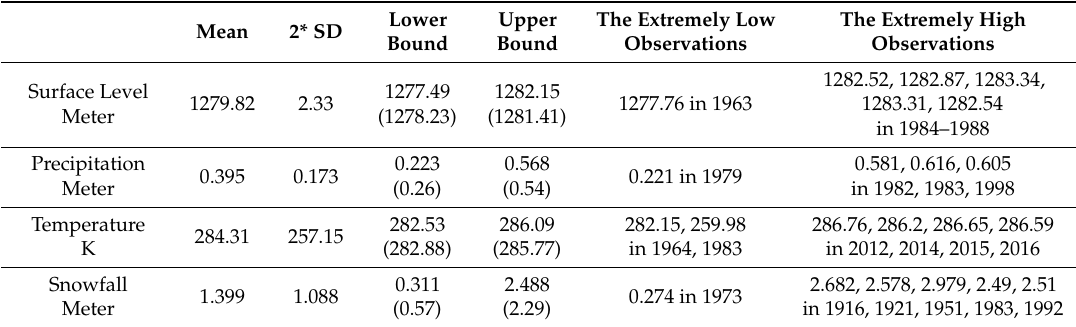
Table 1. Climate, extreme weather, and the surface levels of the Great Salt Lake.